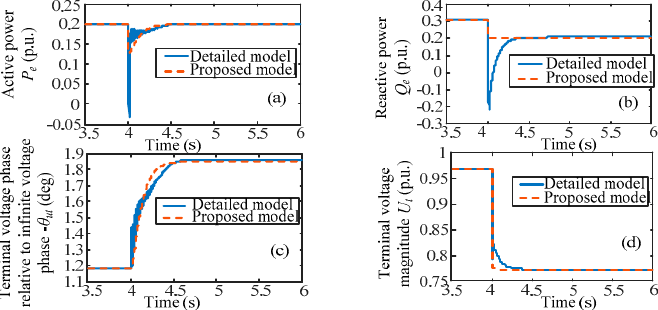
Figure 5. Comparison of simulation responses between the proposed and detailed models when the magnitude of U g decreases 0.2 p.u. at 4 s: ( a ) active power; ( b ) reactive power; ( c ) terminal voltage phase relative to infinite voltage phase; ( d ) terminal voltage magnitude.